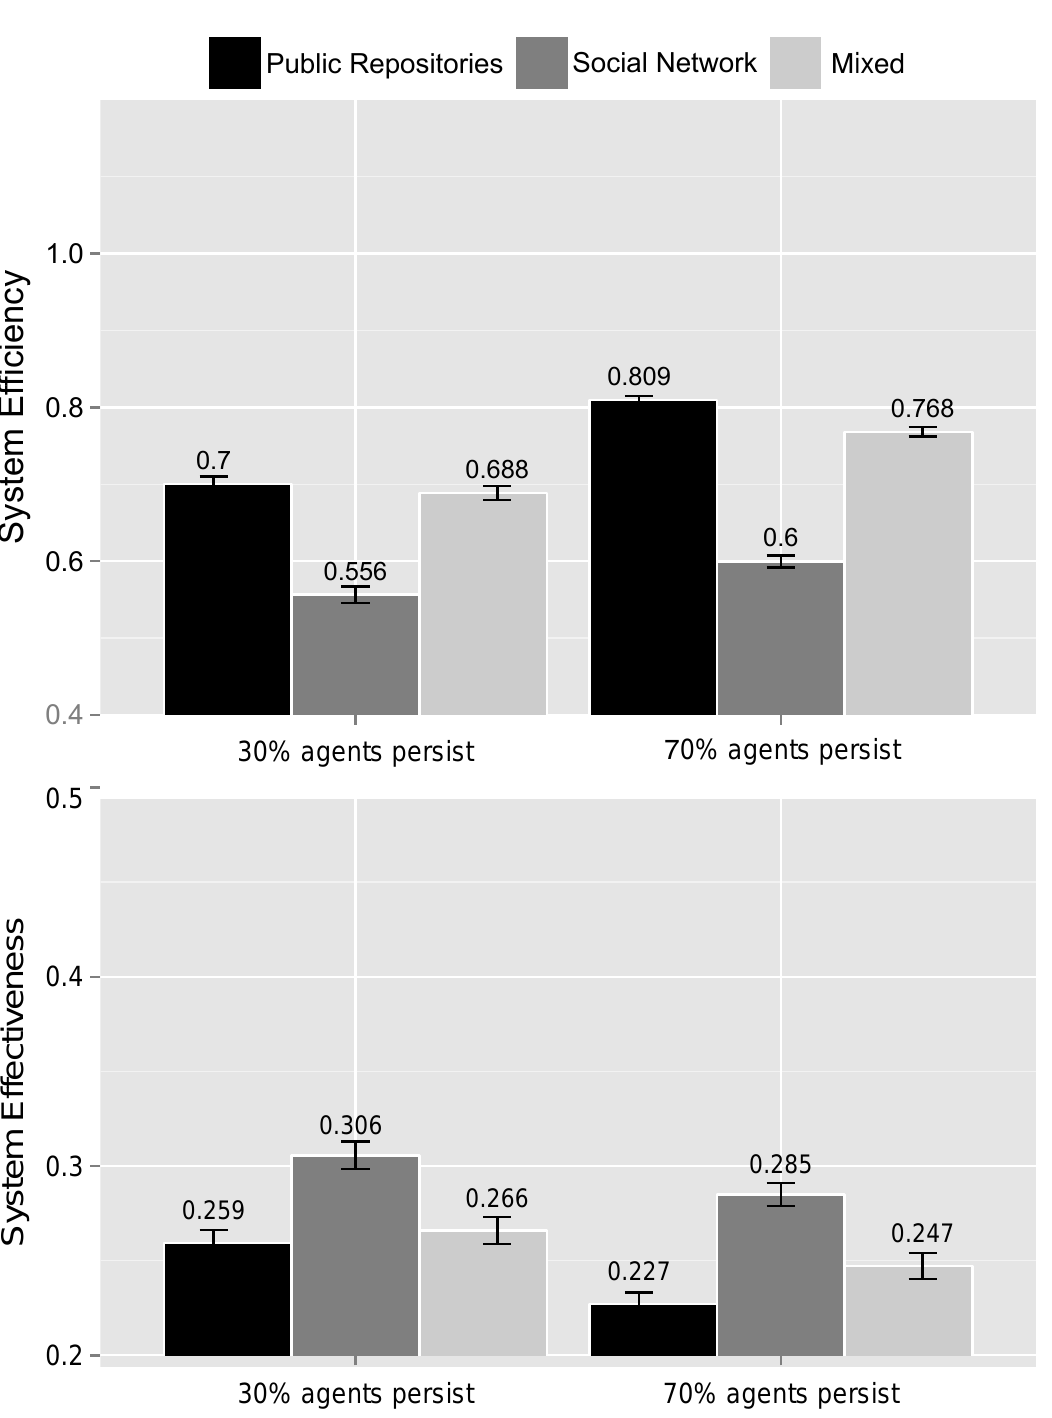
Figure 4: Effects of public repositories, social network, and mixed information on system efficiency and effectiveness (70 percent agents versus 30 percent agents persist with successful strategy) in the knowledge transfer model. The maximum efficiency and effectiveness in both models are normalized to